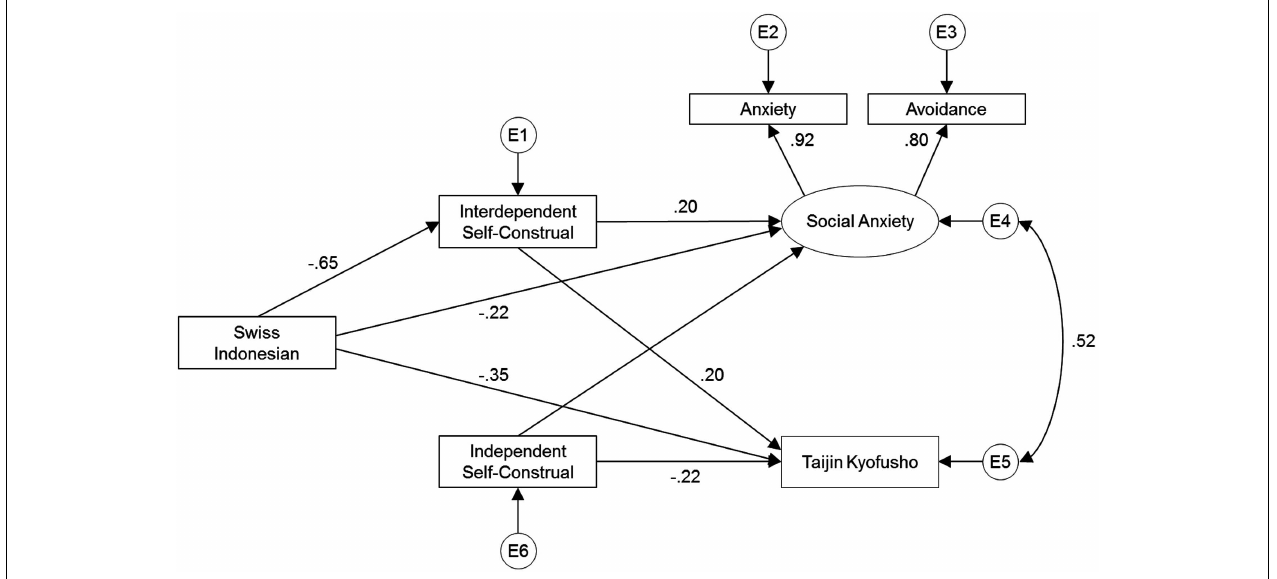
FIGURE 2 | Standardized estimates of the path model with the associations between cultural background (Swiss/Indonesian), self-construal, social anxiety, and taijin kyofusho.